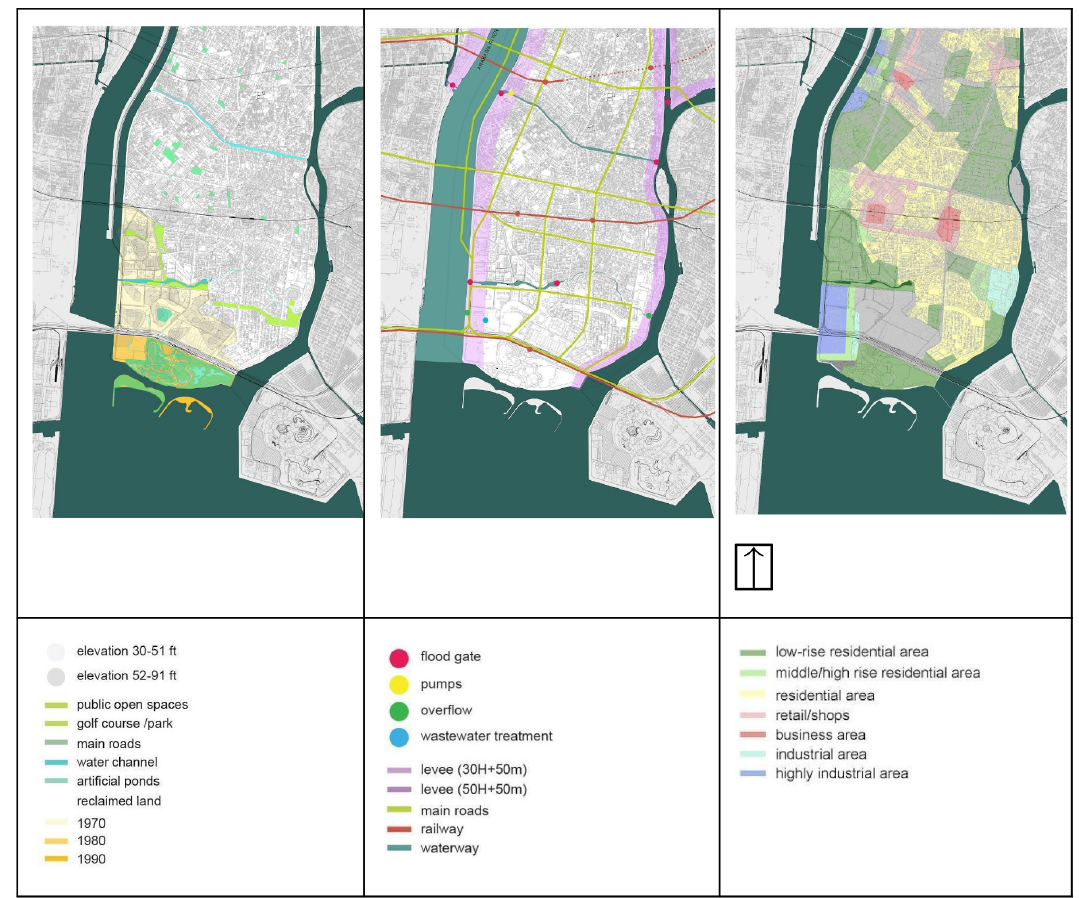
Figure 8. The Dutch layers approach produced a three three-layer mapping of Edogawa ward, Tokyo: ( left ) surface, ( middle ) infrastructure, and ( right ) occupant type (drawn by authors with data and knowledge from